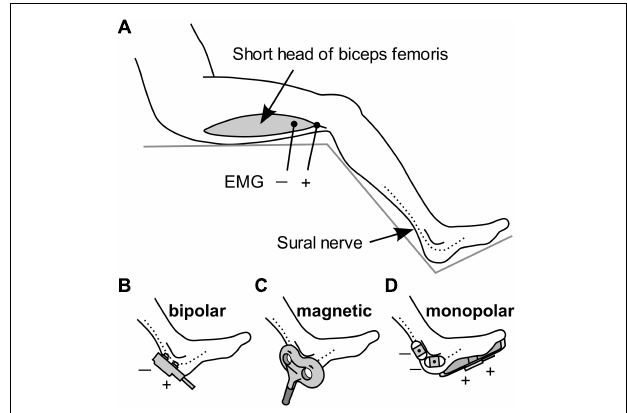
FIGURE 1 | Schematic diagram of the stimulation methods and EMG recordings. (A) Electromyography (EMG) was used for recording flexion reflexes from the biceps femoris. (B–D) Stimulation of the sural nerve by bipolar electrical stimulation, transcutaneous magnetic stimulation, and monopolar electrical